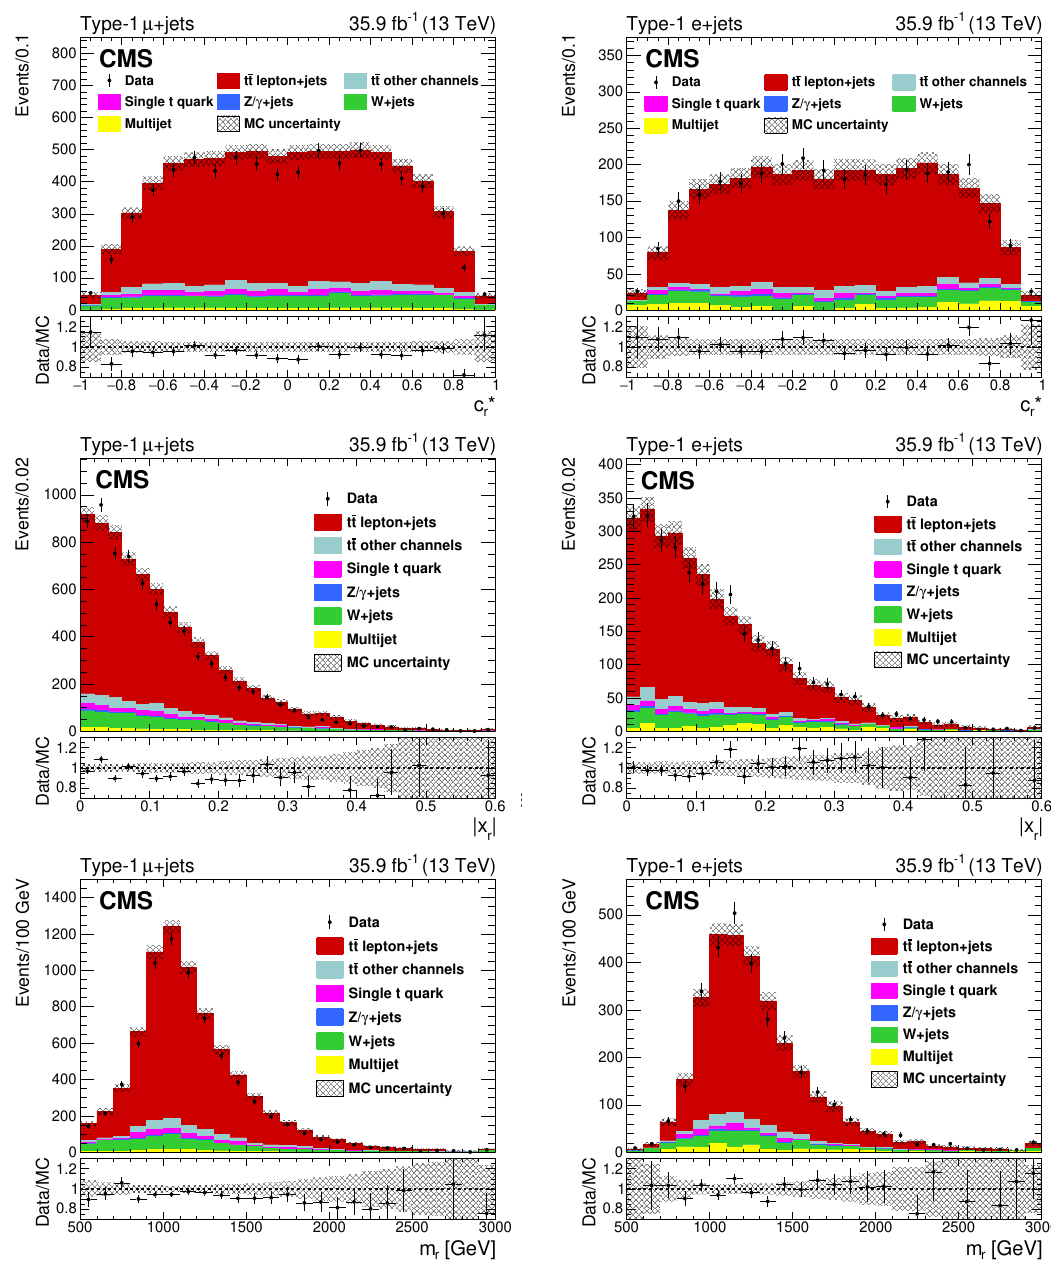
Figure 4 . Reconstructed c (cid:3) (upper), j x j (middle), and m (lower) for events passing type-1 m +jets r r r (left column) and e+jets (right column) selection criteria. The uncertainty pictured in the hatched bands represents just the statistical contributions. The multijet background is estimated from data, as discussed in section 6. The lower panels in each (cid:12)gure show the ratio of data to MC expectation in each bin, and the last bins of the j x j and m plots include over(cid:13)ow. r r